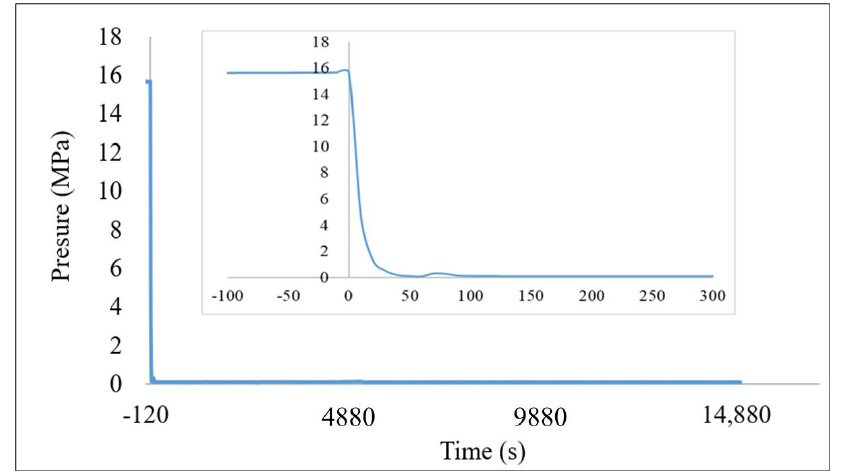
Figure 6. Pressure in the reactor vessel.